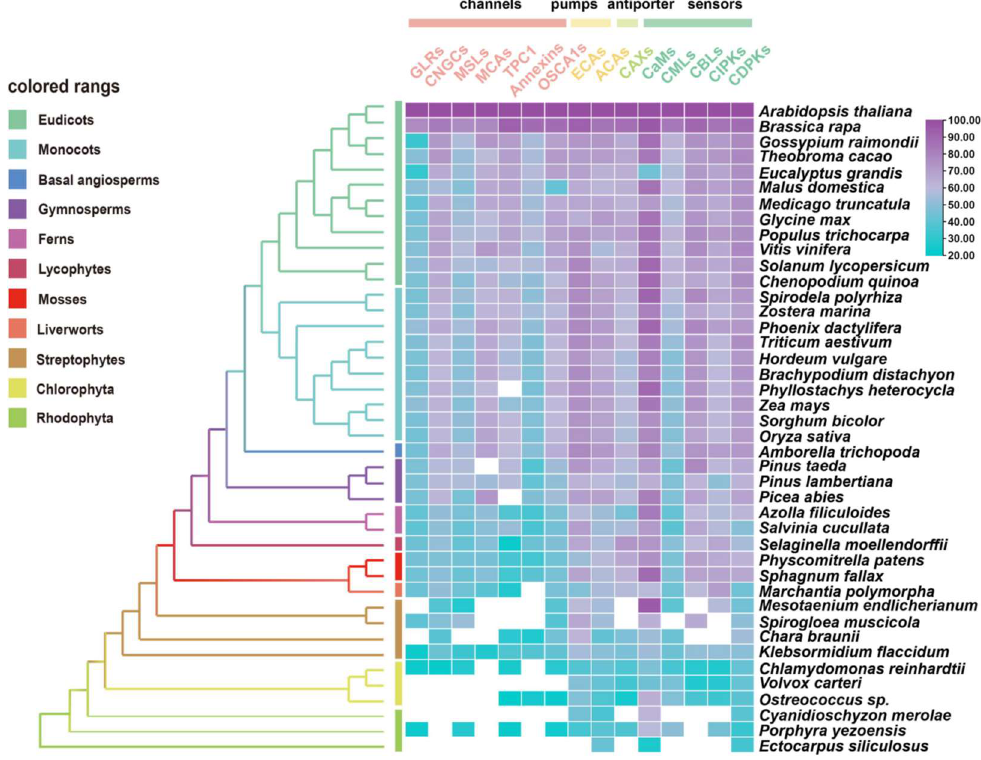
Figure 2. Similarity heat map for the evolution of Ca 2+ signaling relative proteins, containing channels, pumps, antiporters, and sensors in different plant and algal species. Candidate protein sequences were selected by BLASTP searches which satisfied E value < 10 −10 and query coverage > 50% [7]; colored squares indicate a protein sequence similarity from 20% (blue) to 100% (purple). White squares indicate proteins that satisfied neither of the selection criteria. GLRs, glutamate receptor-like channels; CNGCs, cyclic nucleotide gated channels; MSLs, mechanosensitive-like channels; MCAs, ‘mid1-complementing activity’ channels; TPC1, two-pore channel 1; OSCA1s, hyperosmolality-induced Ca 2+ channel 1; ECAs, endoplasmic reticulum-type Ca 2+ -ATPases; ACAs, auto-inhibited Ca 2+ -ATPases; CaMs, calmodulin; CMLs, calmodulin-like protein; CBLs, calcineurin B-like protein; CIPKs, CBL-interacting protein kinases; CDPKs, Ca 2+ -dependent protein kinases.